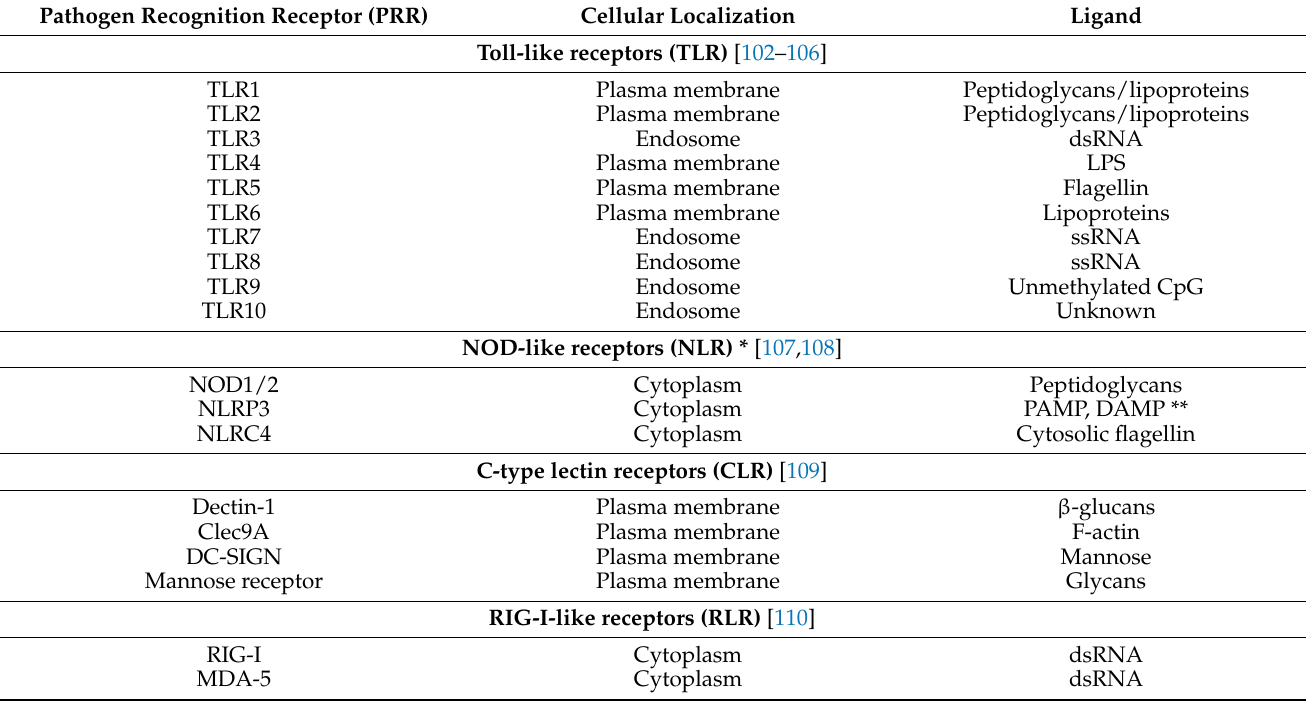
Table 2. Overview of pathogen recognition receptors, with their respective cellular localization and ligands. Pathogen Recognition Receptor